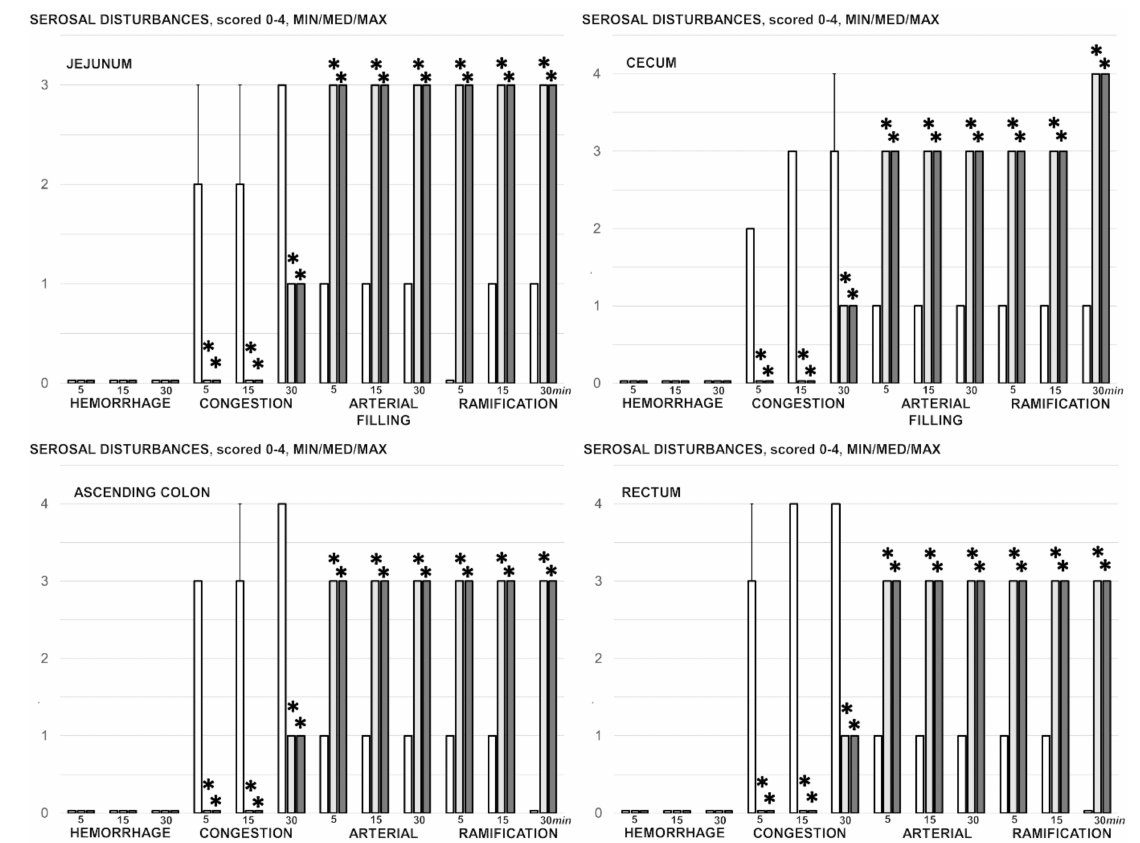
Figure 4. Serosal disturbances (hemorrhage, congestion, arterial filling, ramification), scored 0–4, Min/Med/Max, at 5 min, 15 min and 30 min ligation-time in rats with occluded superior mesenteric vein and artery following medication (BPC 157 10 µ g/kg (light gray bars), 10 ng/kg (dark gray bars); saline 5 mL/kg (white bars) given intraperitoneally. Six rats/group/interval. * p < 0.05, at least vs.